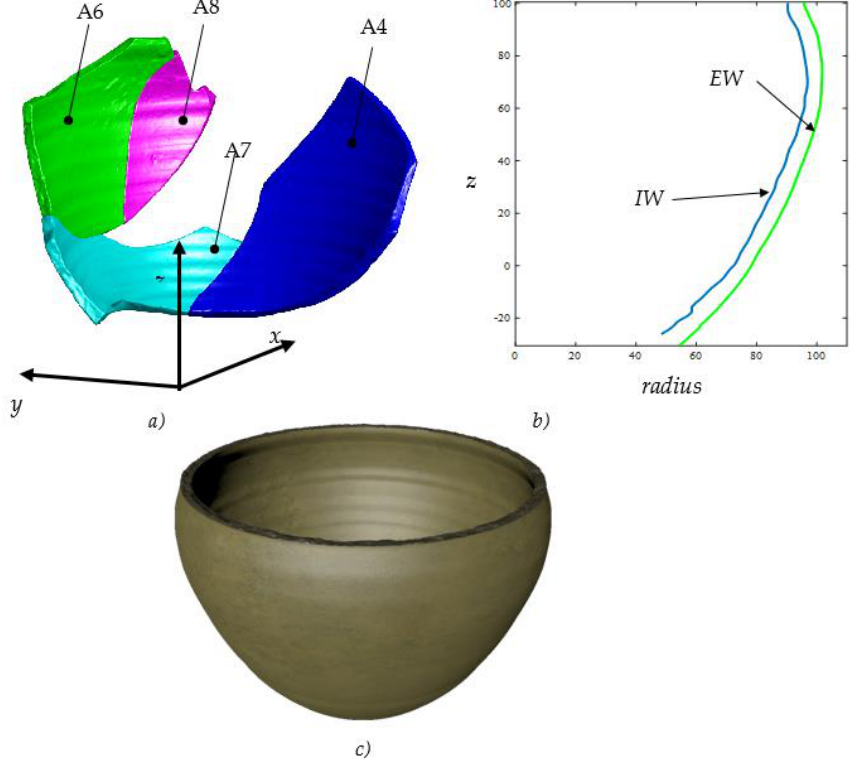
Figure 13. ( a ) The simulated assembly of the four archaeological fragments identified by the algorithm implemented. ( b ) The longitudinal profile and ( c ) the rendering of 3D virtual reconstruction of the archaeological